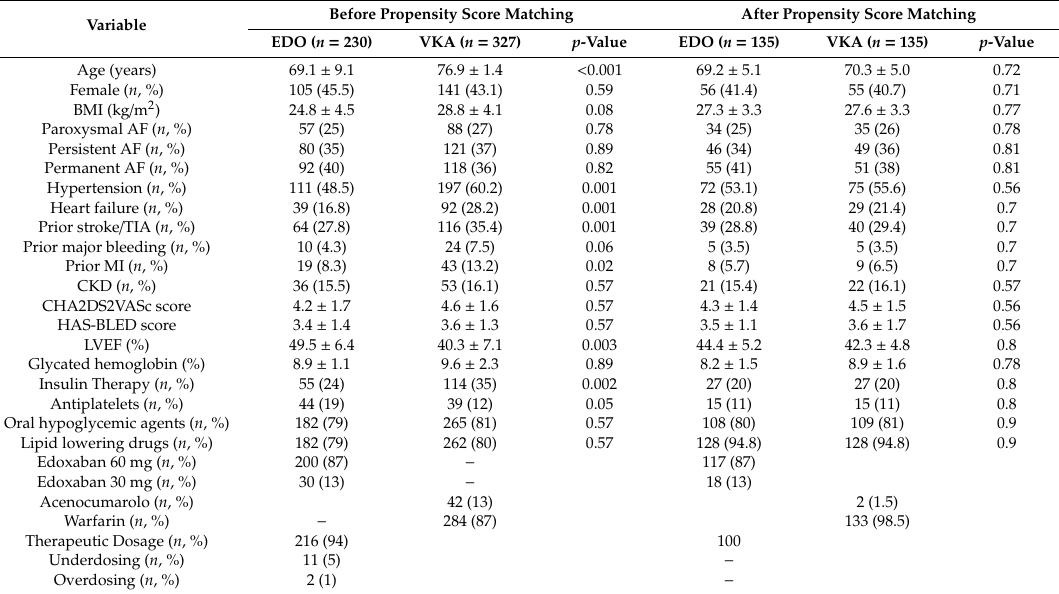
Table 1. Baseline characteristics of the study population before and after propensity matching. Before Propensity Score Matching After Propensity Score Variable